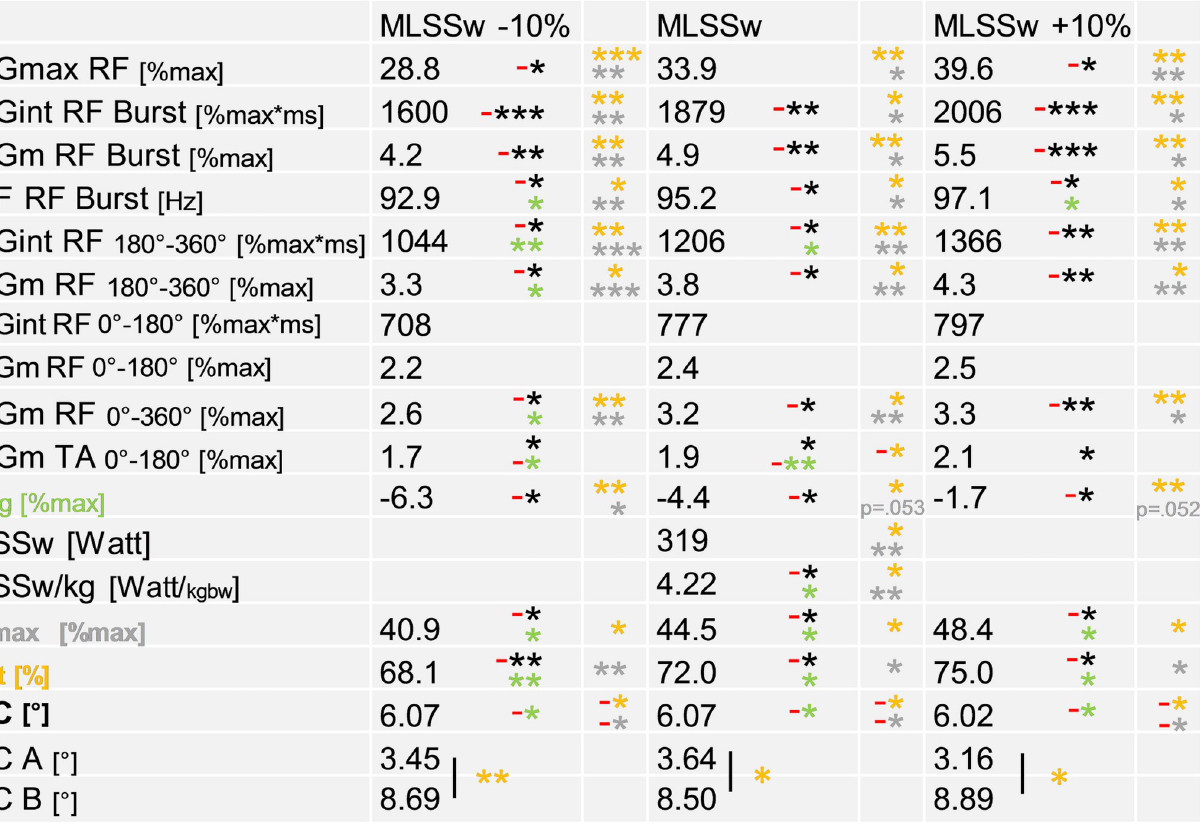
Fig 5. Correlations of force and EMG parameters relevant for coordination and efficient force production in CP-tests (n=14). These data show that the retrievable power at the MLSSw (P%max), the negative power (Pneg) and the mechanical effectiveness (IFEt) is determined by a strong and early activation of the RF in Q3/Q4. DFC, IFEt, Pneg and P%max are correlated to MLSSw/kgbw and are highly influenced by RF activity. Our data suggests that TA activation in the first half of the pedal cycle (Q1, see Figs 2 and 3) impedes cycling performance. Note that DFC is significantly reduced in group A and is inversely correlated to EMG and force/power parameters. Data were calculated for each pedal cycle. P%max and Pneg are shown as mean of both cranks. IFEt is shown as mean of the right crank. For detailed description of data analysis and parameter definitions see Methods and S1 Fig. Black asterisks ( � ): correlation to DFC, grey asterisks ( � ): correlation to P%max, yellow asterisks ( � ): correlation to IFEt, green asterisks ( � ): correlation to Pneg. Shown is mean. � P < 0.05, �� P < 0.01, ��� P <